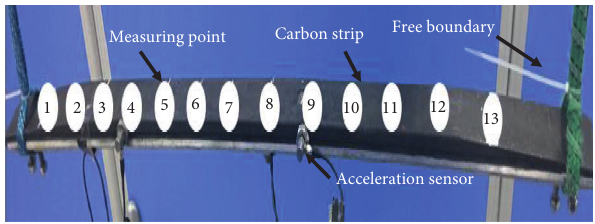
Figure 4: Arrangement of measuring points and acceleration sensors on the carbon strip.